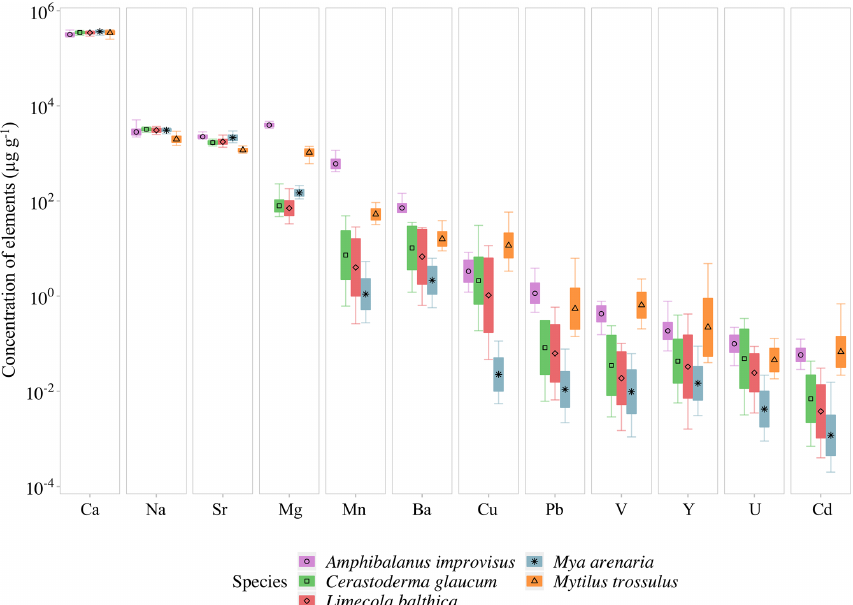
Figure 3. Mean elemental concentrations in shells of studied species. The boxplots represent standard deviations ( ± 1SD) of values, and whiskers indicate the minimum and maximum concentrations for each studied species. Concentrations of elements are presented using a logarithmic scale.